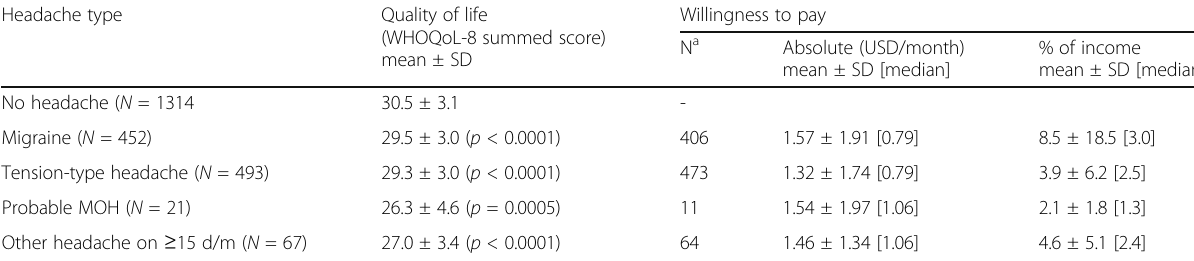
Table 3 Quality of life and willingness to pay for effective headache care, by headache type Headache type Quality of life (WHOQoL-8 summed